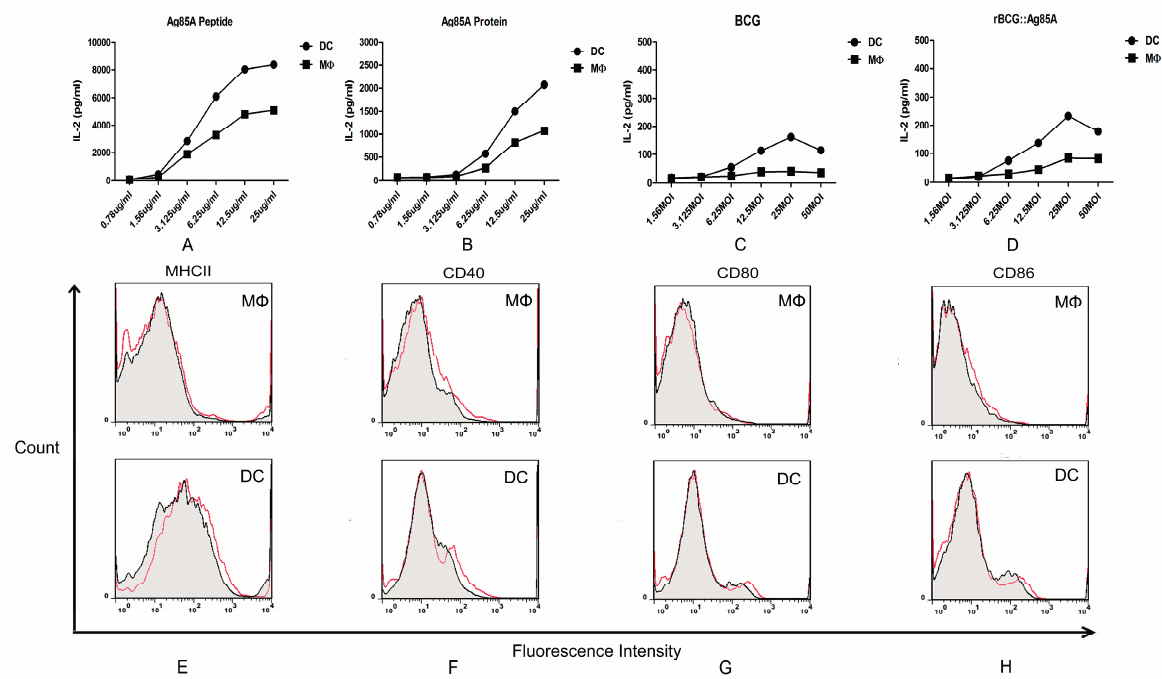
Figure 5. Detection of antigen presenting activity of murine splenic M Φ s and DCs in vitro . Murine splenic macrophages and dendritic cells were treated with serial diluted Ag85A peptide ( A ), Ag85A protein ( B ), and infected with BCG ( C ), rBCG::Ag85A ( D ), then co-cultured with T hybridoma DE10. The change of cell surface MHCII ( E ), CD40 ( F ), CD80 ( G ) and CD86 ( H ) of murine splenic macrophages and dendritic cells in control group (Black) and BCG infected group